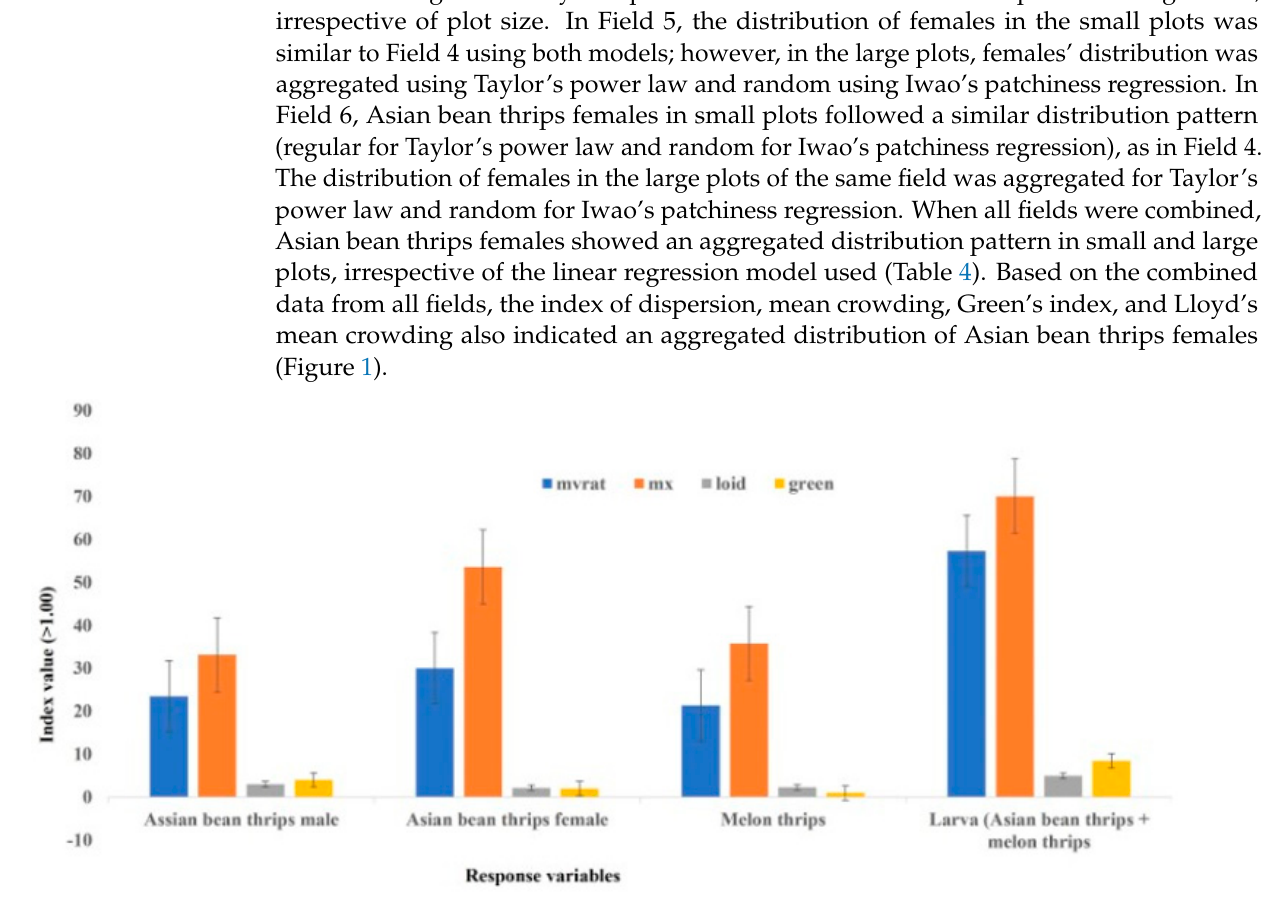
Figure 1. Determination of distribution pattern of thrips using mvratio, index of disperson (mx), Lloid’s index of patchiness and Green’s index. Table 4. Distribution pattern of female Asian bean thrips in various fields based on flower